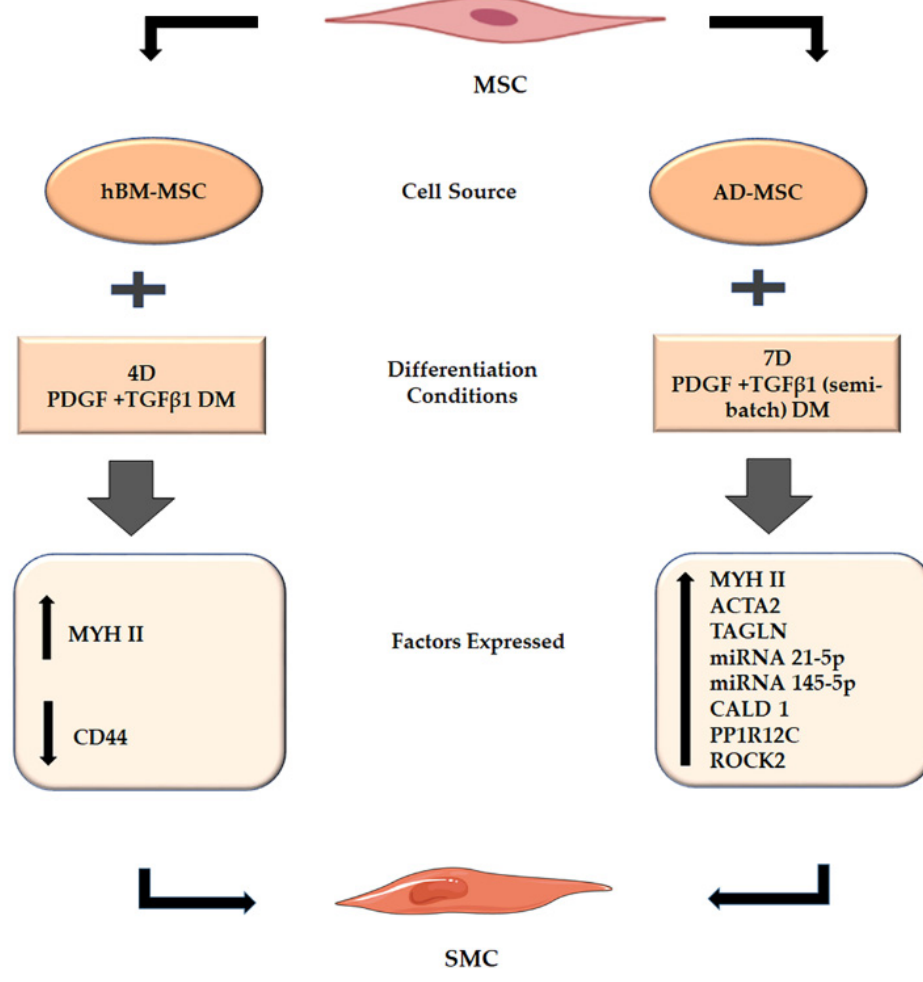
Figure 7. Summary figure describing the MSC differentiation into SMC in our study. PT treatment (batch and semi-batch) on both time points (4Days, 7Days) could elicit various cell markers (hBM-MSC) and RNA sequences (AD-MSC) representative of SMC formation. The cell marker analysis indicated the upregulation in smooth muscle (MYH II) markers and downregulation of stem cell (CD44) markers after PT treatment. The RNA Seq analysis indicated that PT treatment caused upregulation of RNA associated with vascular smooth muscle